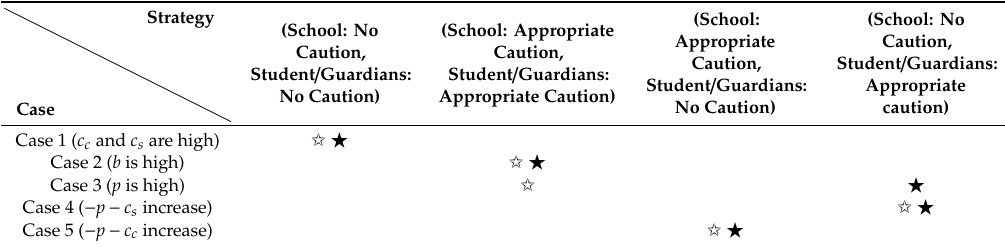
Table 4. Results of the evolution of the system game strategy. ( ☆ is for the strict liability rule. ★ is for the proportional liability rule.)